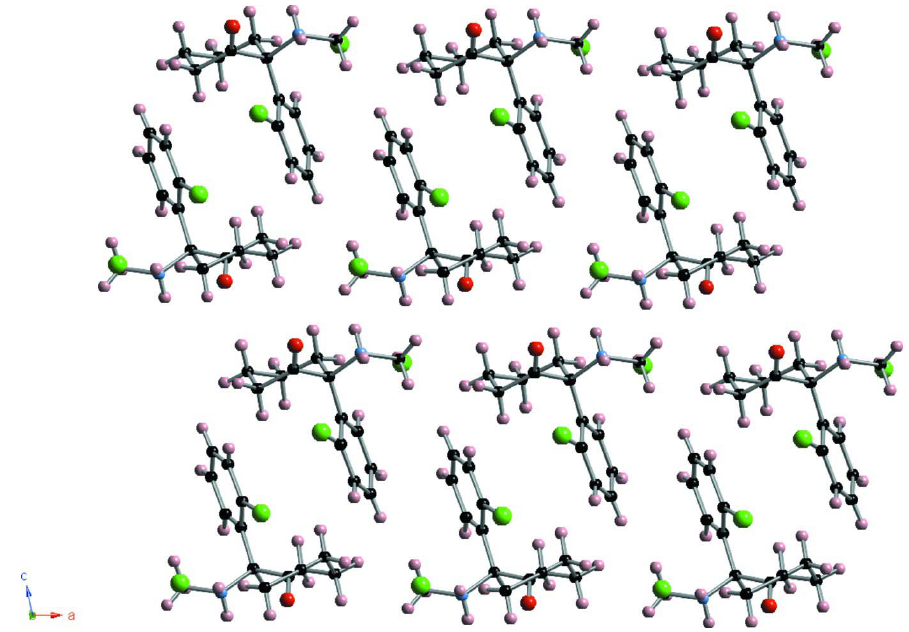
The crystal packing of the title compound viewed along the b